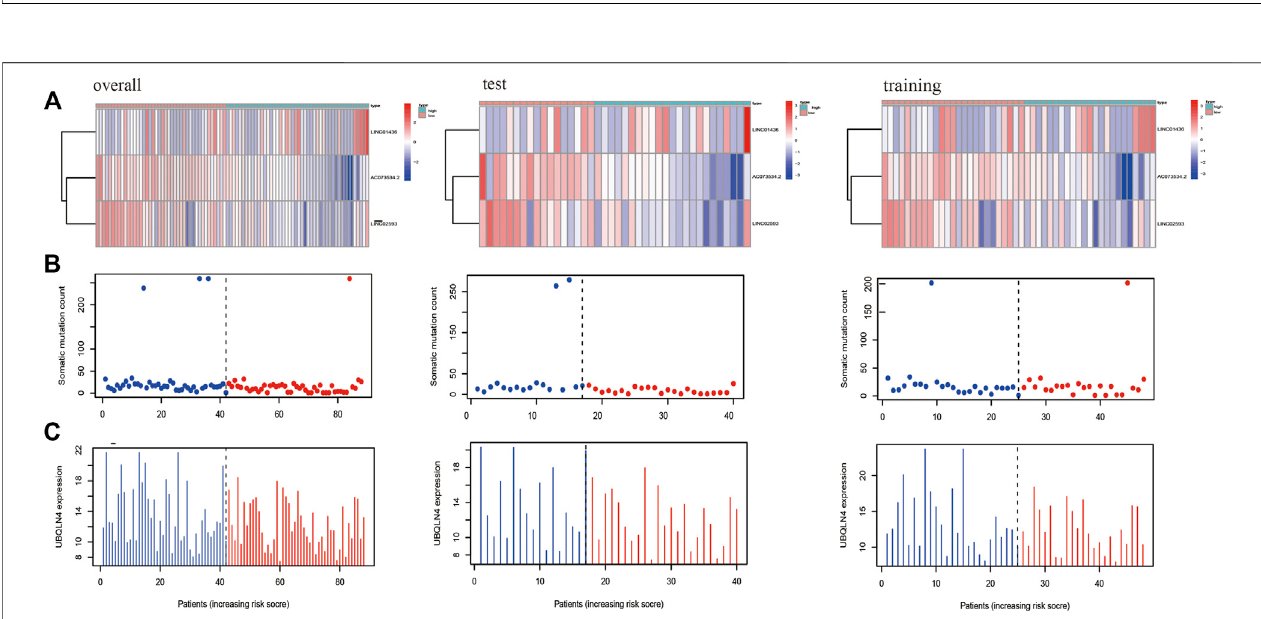
FIGURE 6 | The X -axes of A, B, and C are all samples sorted according to the increasing values at risk. (A) Heat map of the lncRNAs related to the prognostic model; the ordinate represents the three lncRNAs that make up the prognostic model. Red represents upregulation of gene expression, while blue represents downregulation of gene expression. (B) Distribution of gene mutation frequency; the ordinate represents the mutation frequency of each sample. (C) Expression frequency distribution of UBQLN4, the driver of genomic instability; the ordinate is the expression of UBQLN4 in each sample.